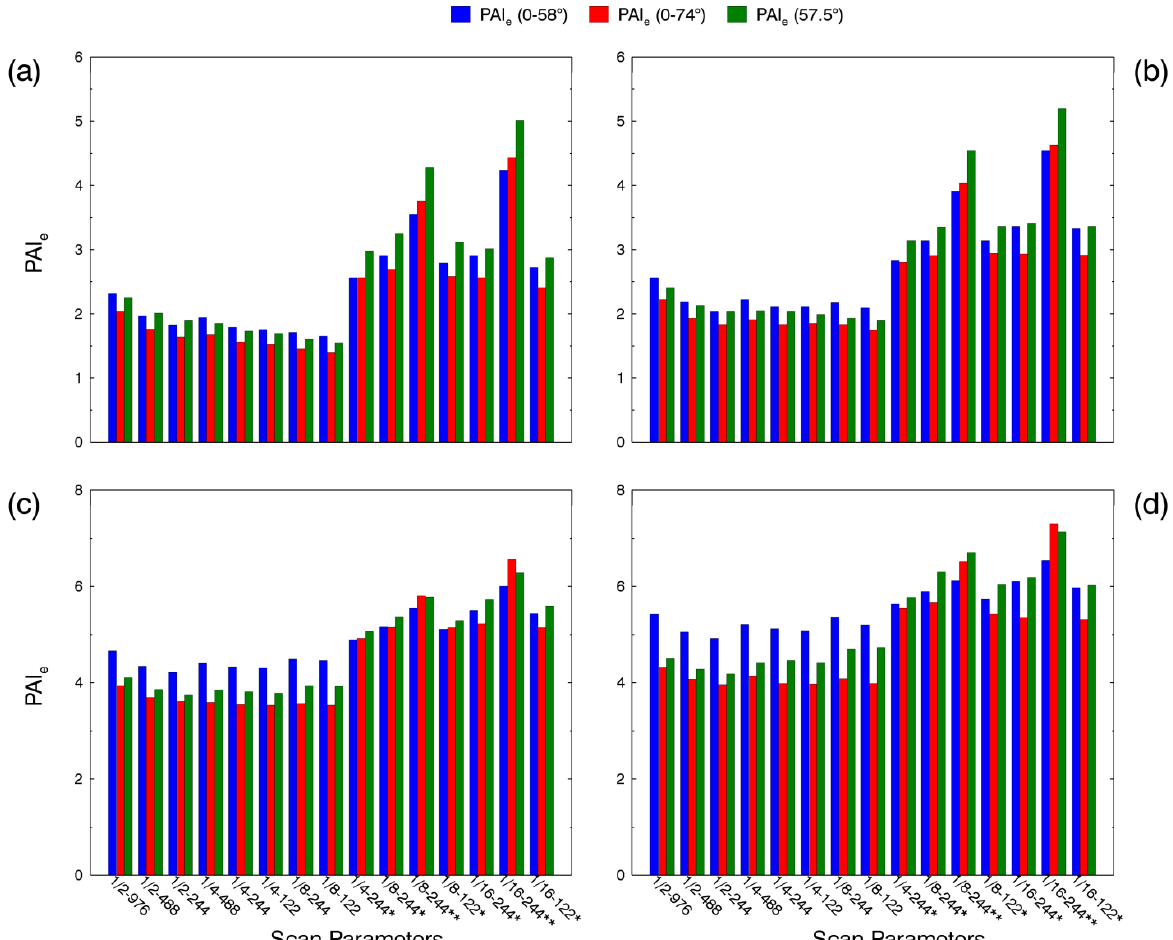
Figure 8. Effective PAI based on the scans collected at the Beech plot with different scan parameters. Leaf-off dates: ( a ) 24 April 2013. ( b ) 2 May 2013. Leaf-on dates: ( c ) 10 May 2013. ( d ) 7 June 2013. Scan parameters: Scan resolution is displayed as the fraction of the maximum scan resolution. Scan speed is displayed in kpts/s. The single and double asterisks denote scans performed with the 2-factor and 4-factor noise